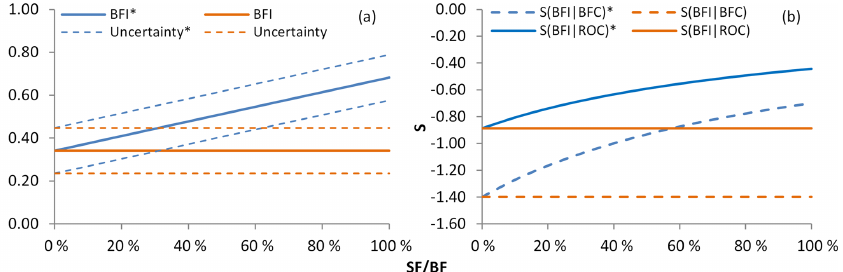
Figure 3. Estimation results of (a) baseflow index and uncertainty (b) sensitivity indices, under different low-conductivity soil flow ratios, assuming high-conductivity baseflow remains unchanged. An asterisk indicates the results of the estimation considering the low-conductivity soil